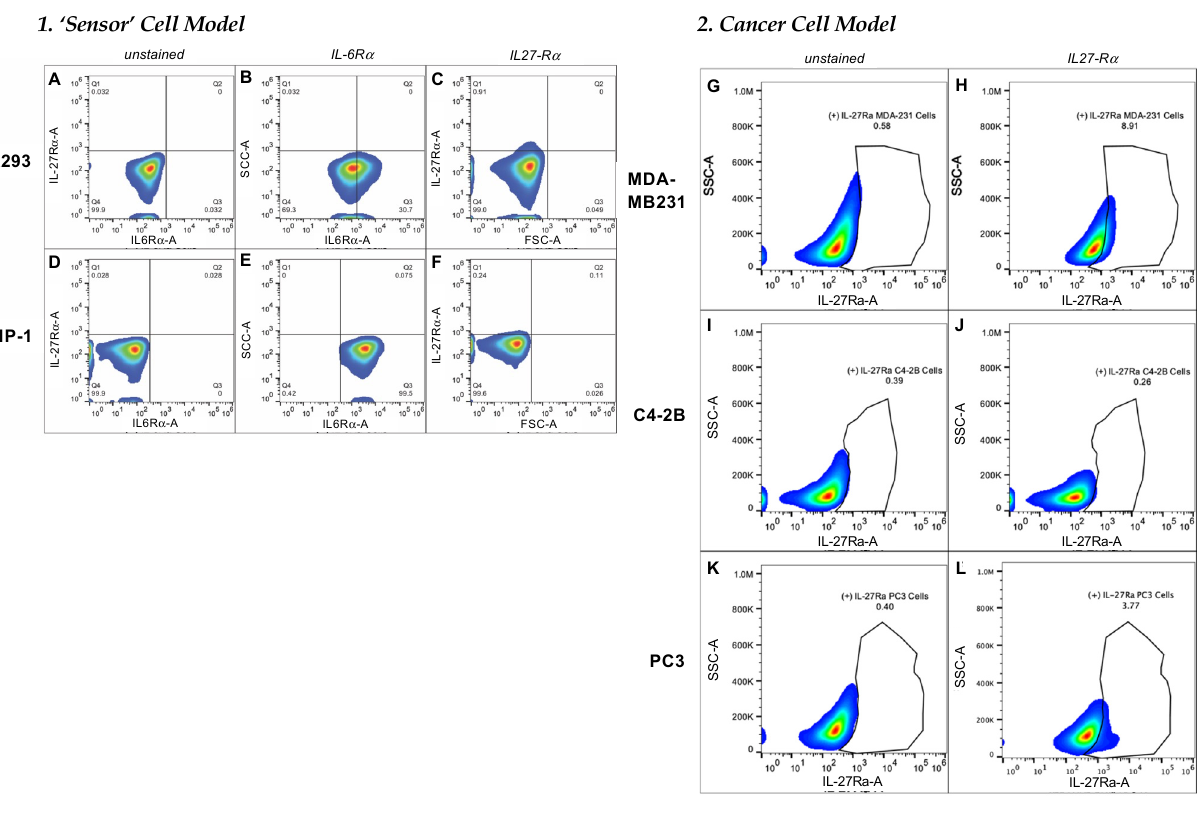
Figure 4. IL-6R α - and IL-27R α -expression profile on surfaces of cells utilized as reporter or ‘sensor’ cells to validate 2nd-generation Nanoluc-27 targeting. Both ( A , D ) are unstained controls of sensor cells. Around 30% of HEK293 cells displayed IL-6R α , whereas ~90% of THP-1 cells displayed the receptor on their cell surface in measurable densities ( B , E ). Both HEK293 and THP-1 displayed negligible densities of IL-27R α ( C , F ). 2. IL-27R α -expression profile on surface of cancer-cell models. ( G , I , K ) are unstained controls of model cells. IL-27R α -expression levels in MDA-MB231 (positive control) at 8.91% ( H ), C4-2B cells at 0.26% ( J ), and PC3 cells at 3.77% ( L ).